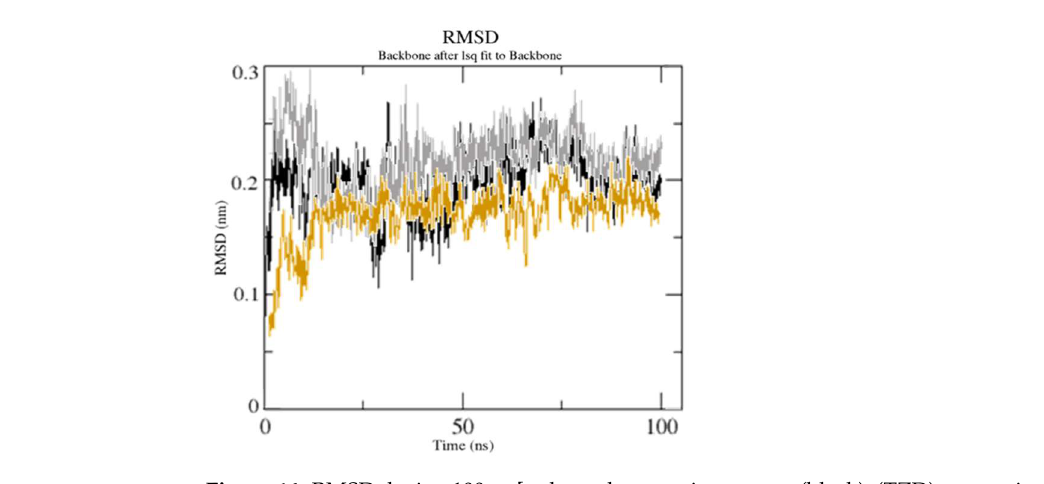
Figure 14. RMSD during 100 ns [unbound serotonin receptor (black), (TZD)-serotonin complex (gray), and [(TZD)(DCQ)]-serotonin complex (orange)].